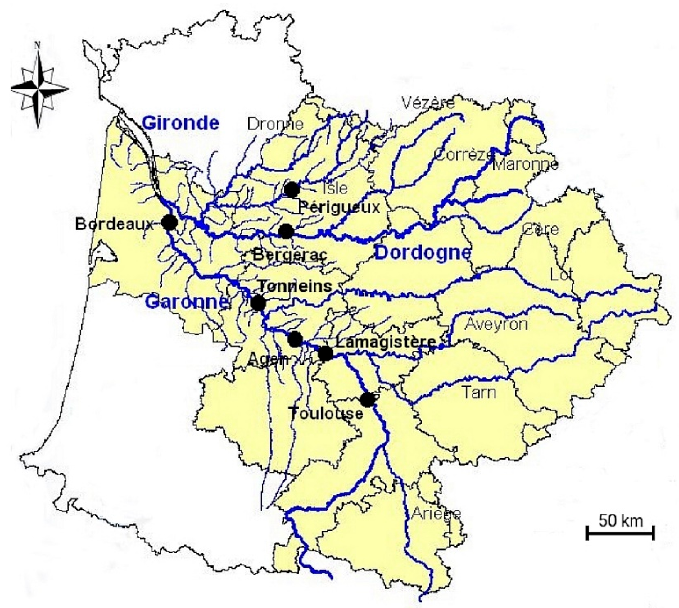
Figure 1. The Garonne catchment with the names of main rivers (blue) and tributaries (black), and the names of main cities (dark black).